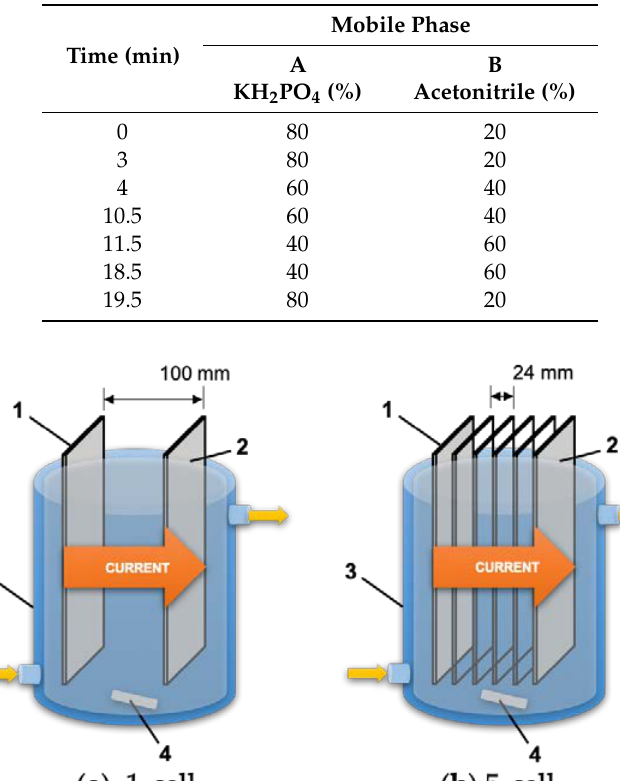
1 L) with a water bath. 4: ∀ =